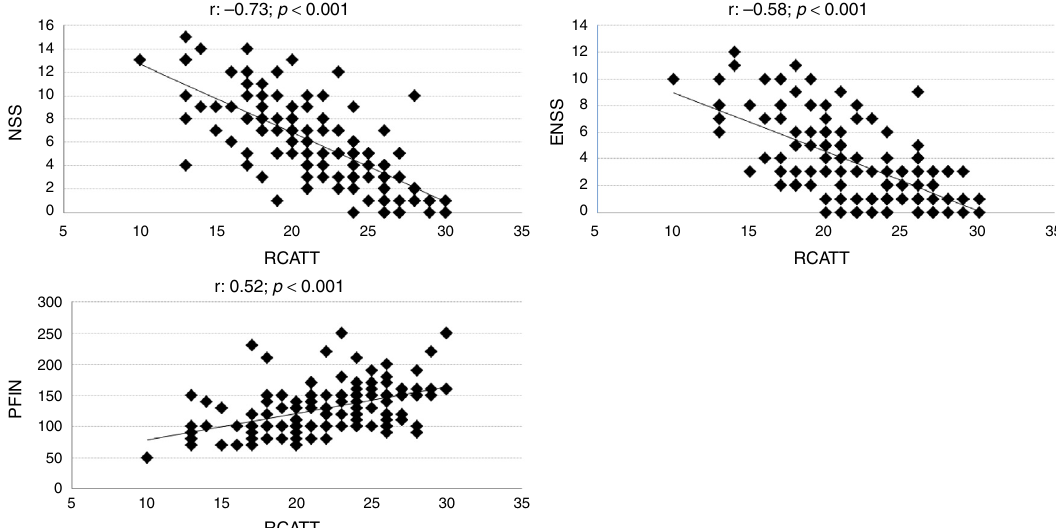
Figure 2 Correlation between total Rhinitis Control Assessment Test (RCAT) scores (RCATT) and Nasal Symptom Score (NSS), Extra-Nasal Symptom Score (ENSS), and Peak Nasal Inspiratory Flow (PNIF) values.